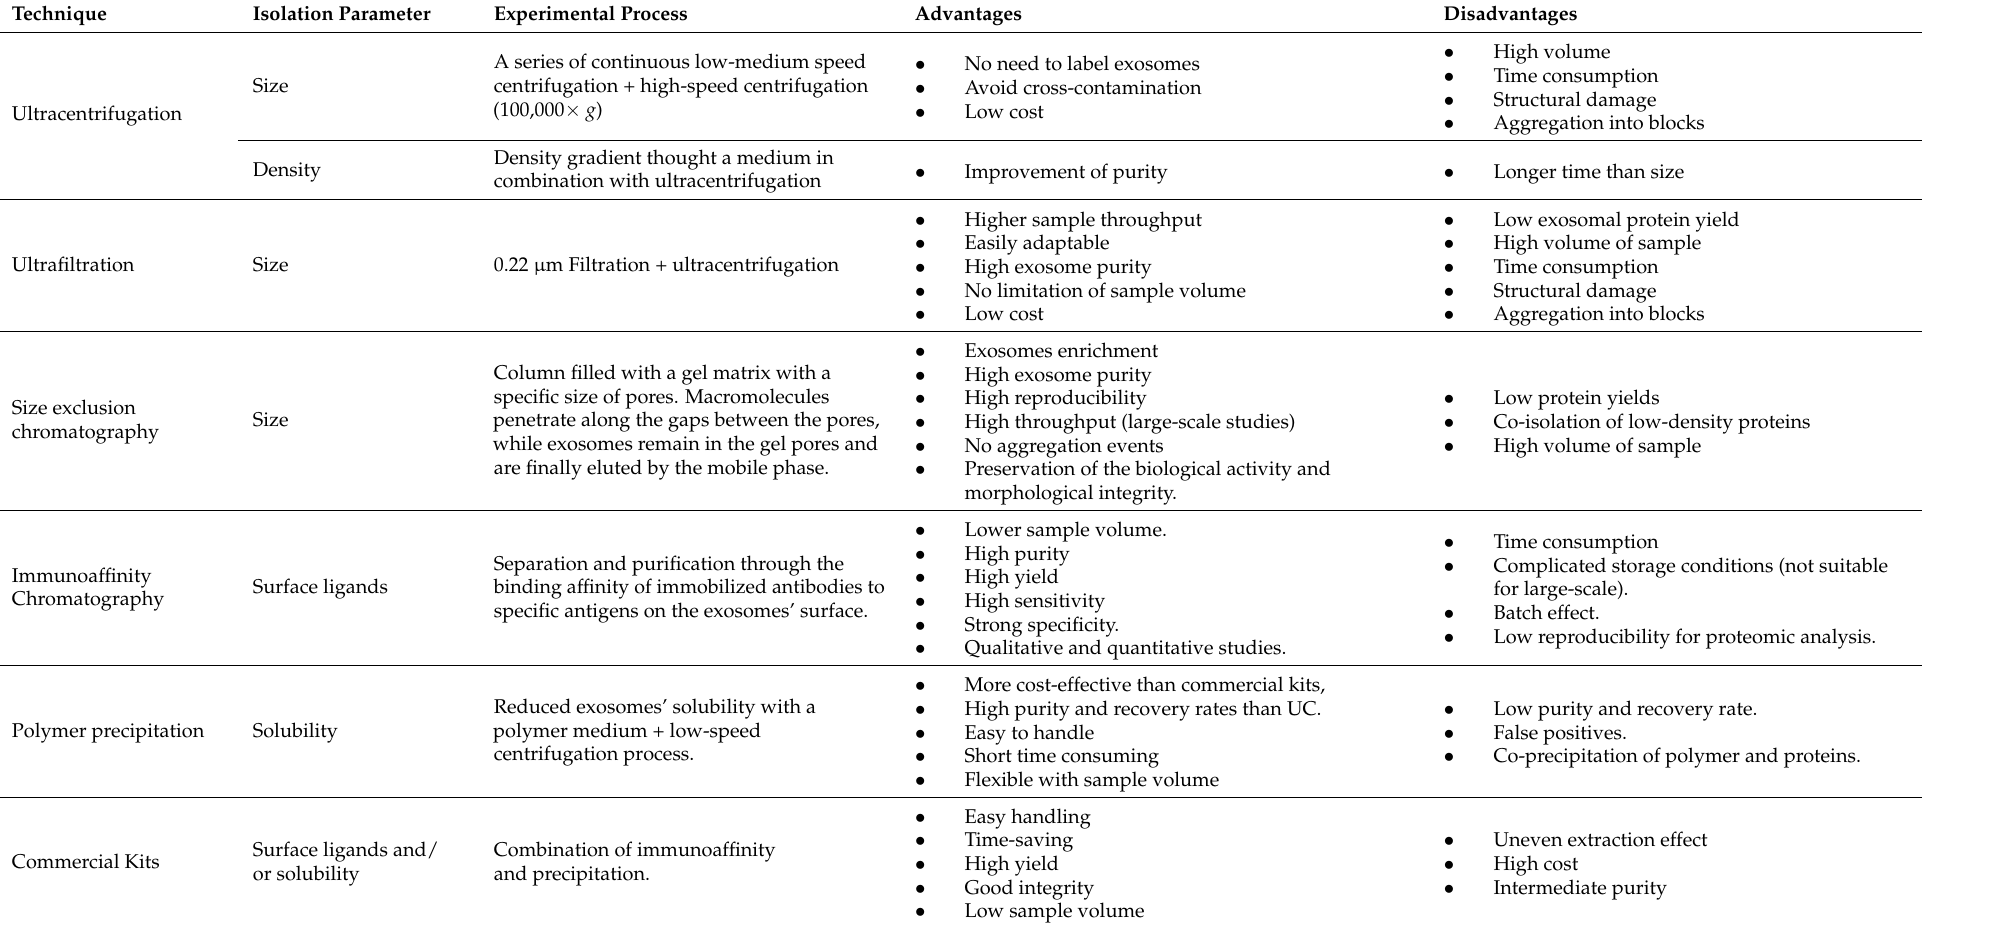
Table 2. Main characteristics of isolation methods of exosomes